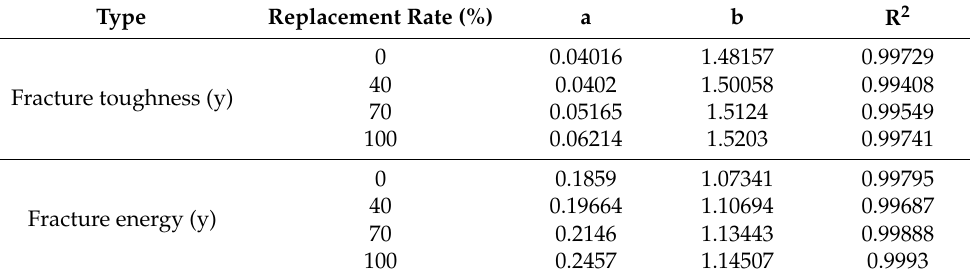
Table 4. Freeze–thaw damage parameters of gangue concrete fracture toughness and fracture energy under different gangue replacement